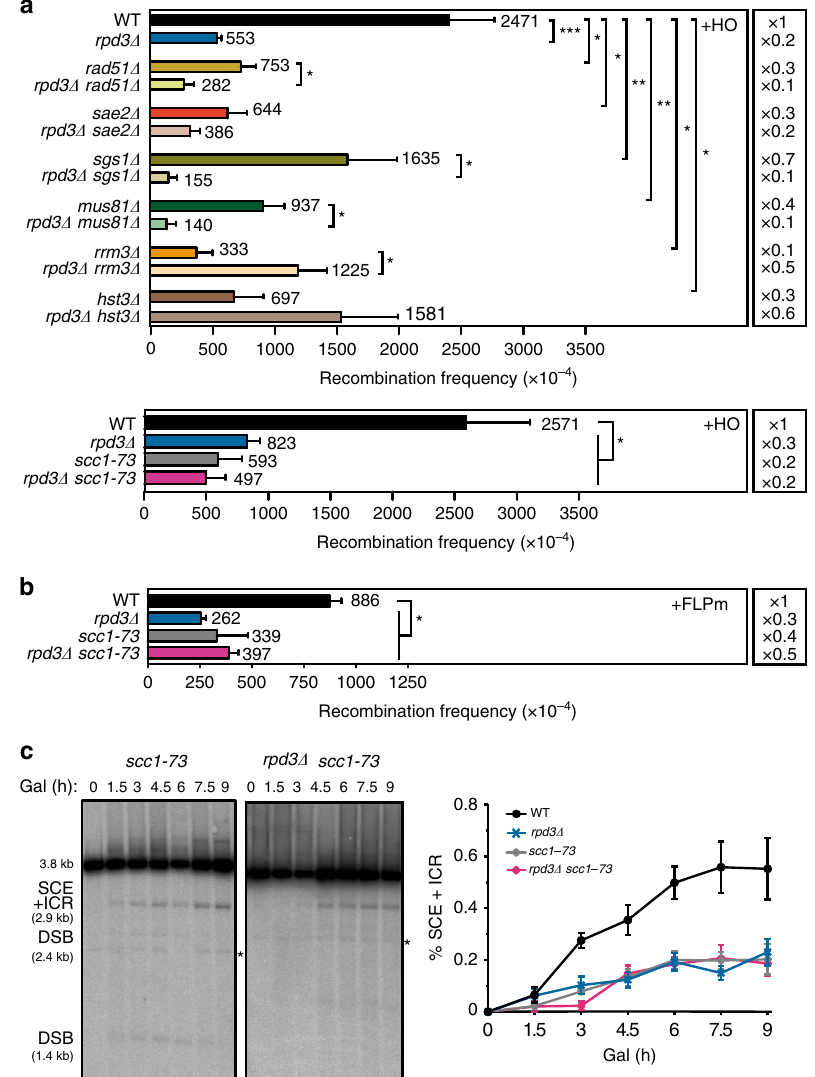
Fig. 6 SCE levels in rpd3 Δ in combination with other SCR-affected mutants. a Analysis of HO-induced recombination frequencies at 30 °C (upper panel) and 33 °C (lower panel) in wild type (WSR-7D), rpd3 Δ (WSRPD3b), rad51 Δ (WSRAD51), rpd3 Δ rad51 Δ (WSR3R5), sae2 Δ (WSSAE2), rpd3 Δ sae2 Δ (WSR3S2), sgs1 Δ (WSSGS1), rpd3 Δ sgs1 Δ (WSR3SG), mus81 Δ (WSMUS81), rpd3 Δ mus81 Δ (WSR3M8), rrm3 Δ (WSRRM3), rpd3 Δ rrm3 Δ (WSR3RR), hst3 Δ (WSHST3), rpd3 Δ hst3 Δ (WSR3H3), scc1-73 (WSSCC1), and rpd3 Δ scc1-73 (WSR3S1) strains transformed with pRS316-TINV ( n ≥ 3). b Analysis of FLPm- induced recombination frequencies at 33 °C in wild type (WFLP), rpd3 Δ (WFRPD3), scc1-73 (WFSCC1), and rpd3 Δ scc1-73 (WFR3S1) strains transformed with pTINV-FRT ( n = 3). c Representative Southern blots and quanti fi cation of the 2.9-kb SCE + ICR fragments during a time-course experiment after FLPm induction performed at 37 °C in wild type (WFLP), rpd3 Δ (WFRPD3), scc1-73 (WFSCC1), and rpd3 Δ scc1-73 (WFR3S1) strains transformed with pTINV-FRT ( n ≥ 3). Other details as in Fig. 4b. Means and SEM are plotted in all panels. In a and b * p ≤ 0.05; ** p ≤ 0.01 (two-tailed Student ’ s t- test). See also Supplementary Fig. 4. Data underlying this fi gure are provided as Source Data fi